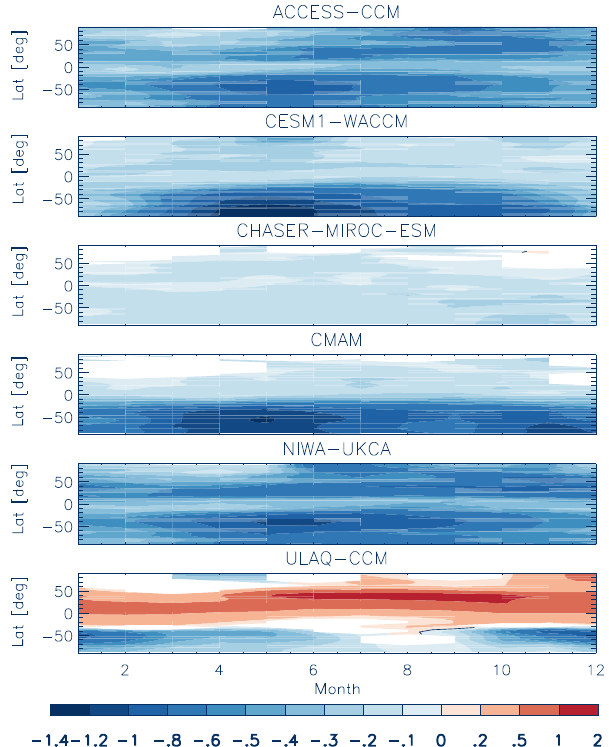
Figure 9. Ratio of zonal-mean surface ozone changes to changes in surface Cleq . (in ppbvppbv − 1 ) as derived from the REF-C2 and SEN-C2-fODS